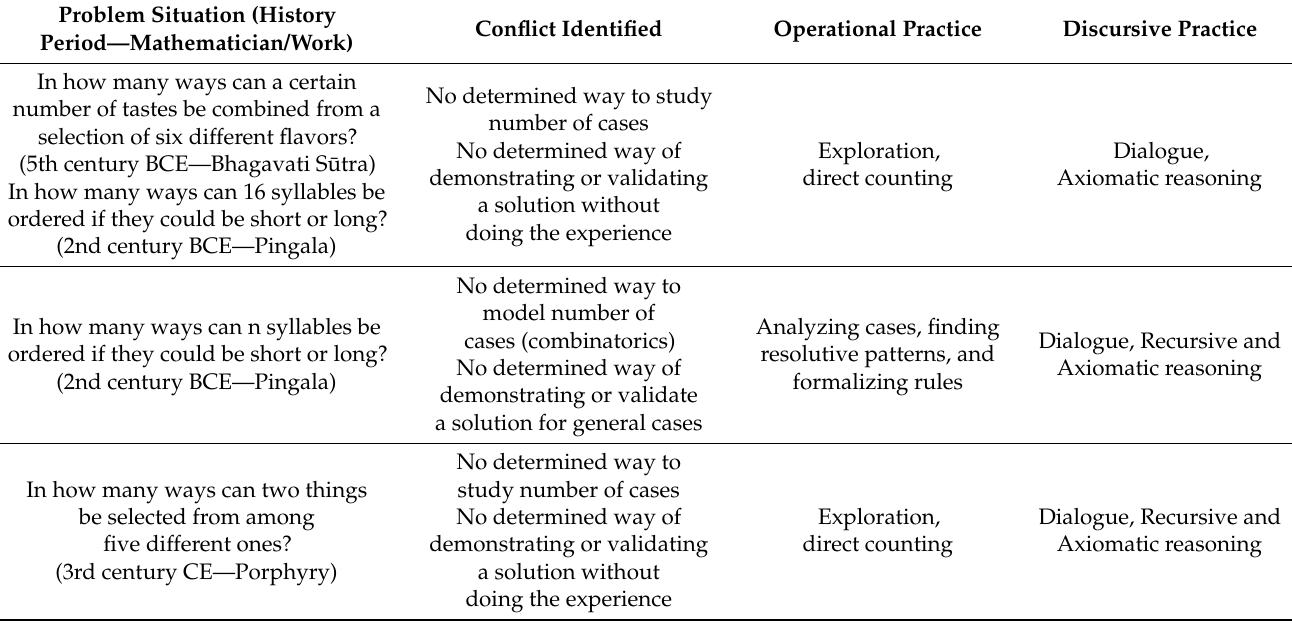
Table 1. Historical problem situations (600 BCE—14th